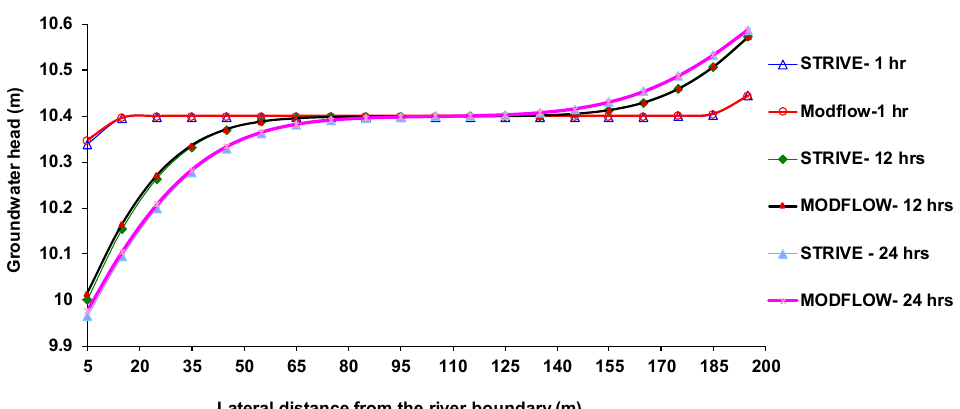
Figure 16. Groundwater head versus lateral distance from the river-aquifer boundary at 505 m from the upstream river for FEMME and MODFLOW, based on interpolated river boundary with a transient simulation.